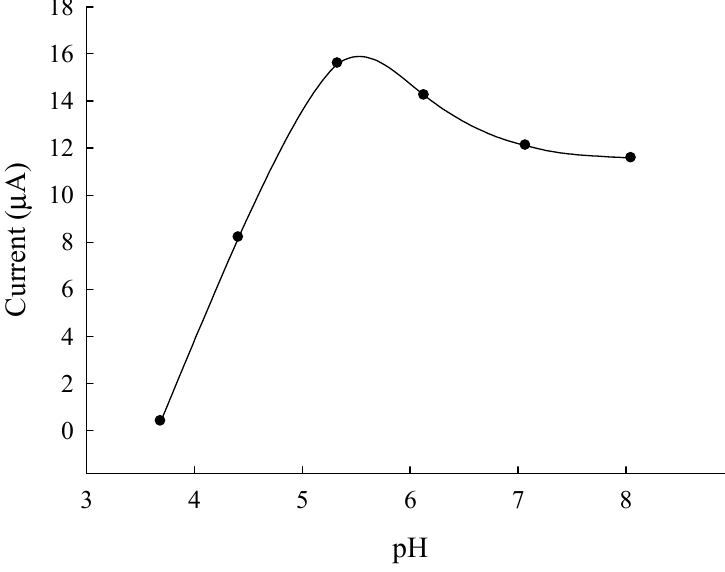
Figure 3. The effect of pH on the response current of cysteine (1.2 mg·L − 1 ) in Britton-Robinson buffer at Au modified CFE; CV scan rate, 50